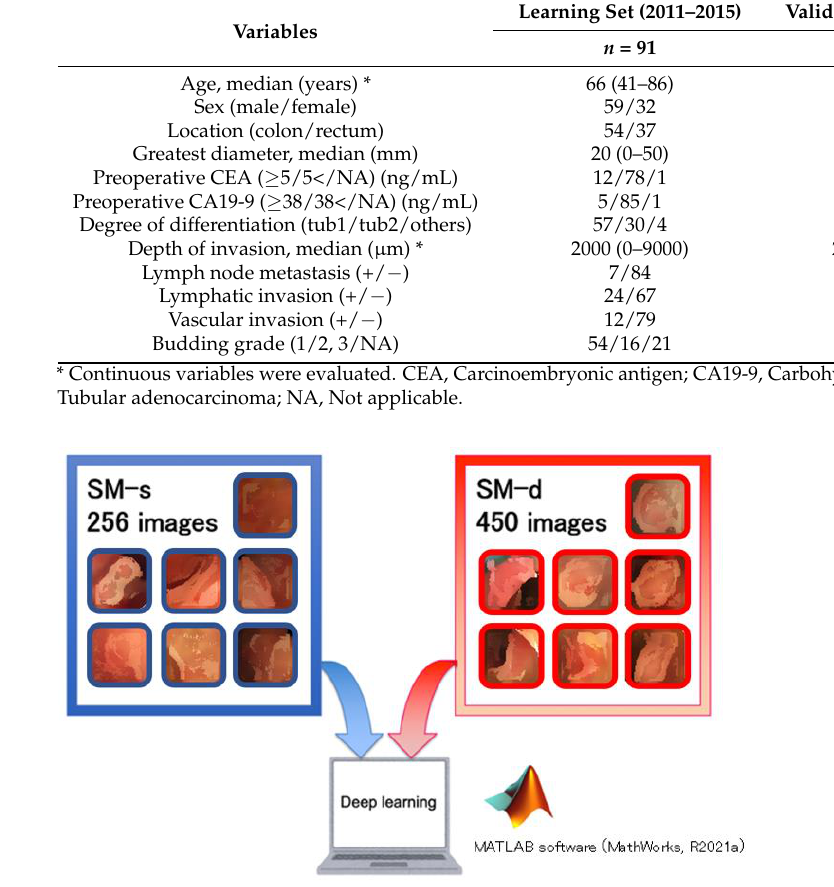
Table 1. Clinicopathological feature.